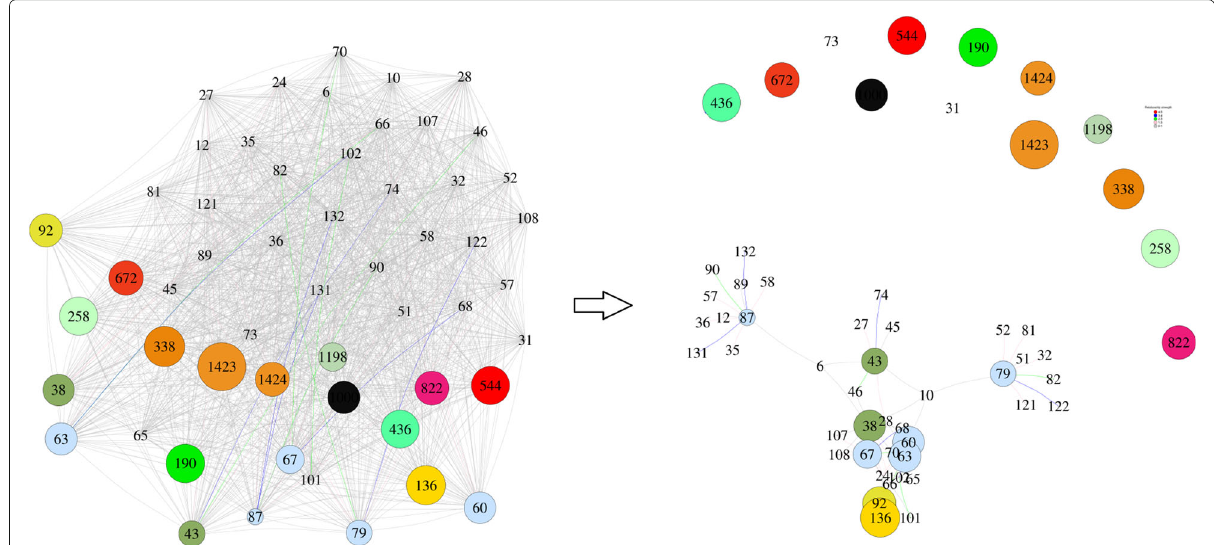
Fig. 6 The initial graph and the clustered graph of the NYTimes